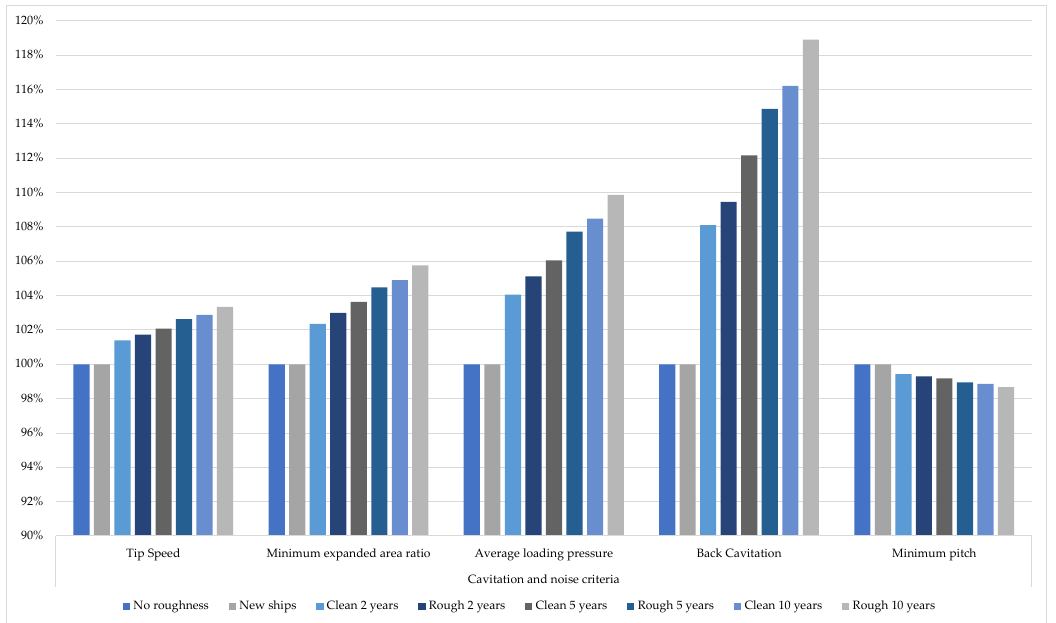
Figure 3. Percentage of changing cavitation and noise criteria for different hull roughness.